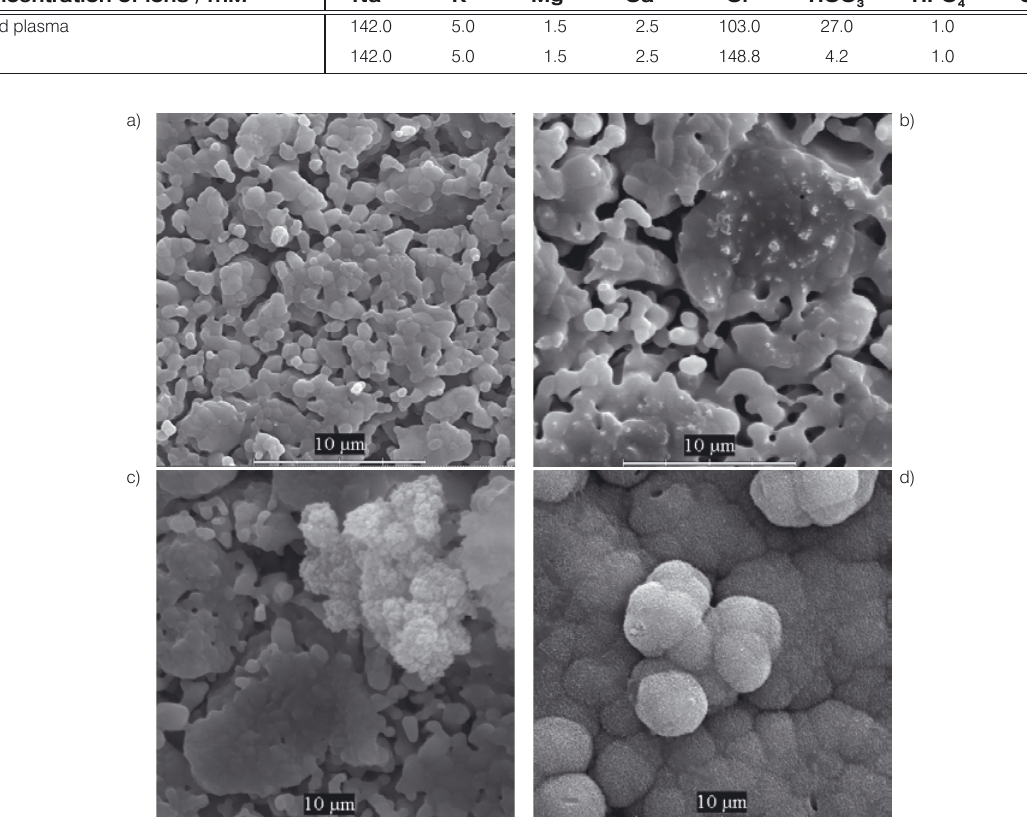
Table 1 . Concentration of ions in SBF and in human blood plasma. Concentration of ions / mM